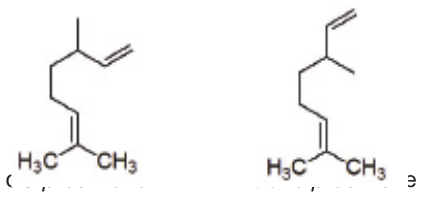
Fig. 1. Structures of two β -ocimene stereoisomers, cis - and trans - β -ocimene (also referred to as (Z)- and (E)- β -ocimene, respectively) Trans - β -ocimene occurs in 71% of the 90 plant families in the list of identified floral-scent compounds compiled by Knudsen et al [13]. Ocimene is widely used as a perfumer agent in the cosmetic industry due to the pleasant